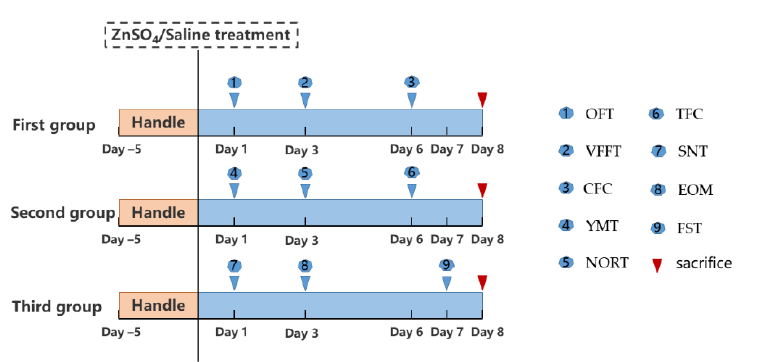
Figure 1. An illustration of the experimental timeline. Open field test, OFT; elevated O maze, EOM; forced swim test, FST; Y-maze test, YMT; novel object recognition test, NORT; contextual fear conditioning test, CFC; tone-cued fear conditioning test, TFC; social novelty test, SNT; von Frey filaments test, VFFT.